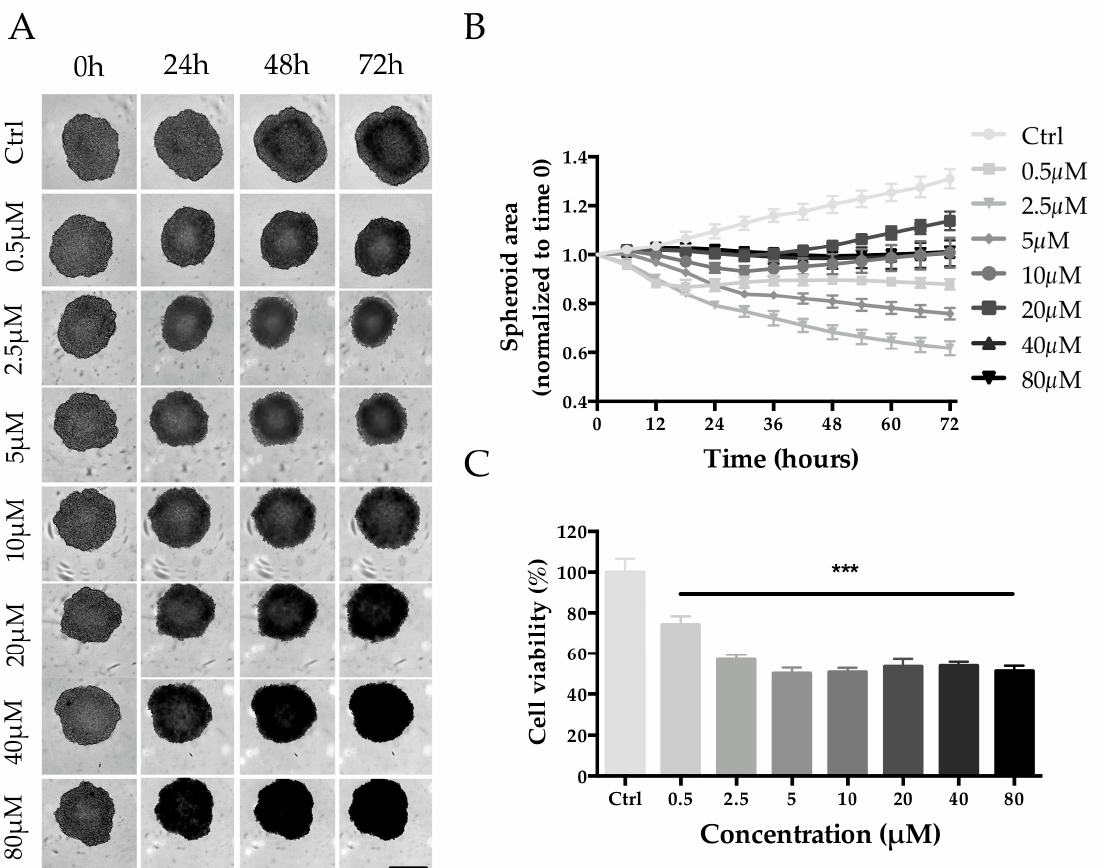
Figure 8. Effect of MTX on HepG2 spheroid size and cell viability. ( A ) Phase-contrast images (Incucyte ® ) of MTX-treated spheroids recorded every 24 h. Scale bar 400 μ m. ( B ) Spheroid size calculated by using the Incucyte ® Zoom Software every 6 h. ( C ) Spheroid viability after 72 h of treatment with MTX at a final concentration of 80, 40, 20, 10, 5, 2.5, and 0.5 μ M. Viability is expressed as the percentage of resazurin reduction with respect to the control. *** denotes p < 0.001 vs. the ctrl.